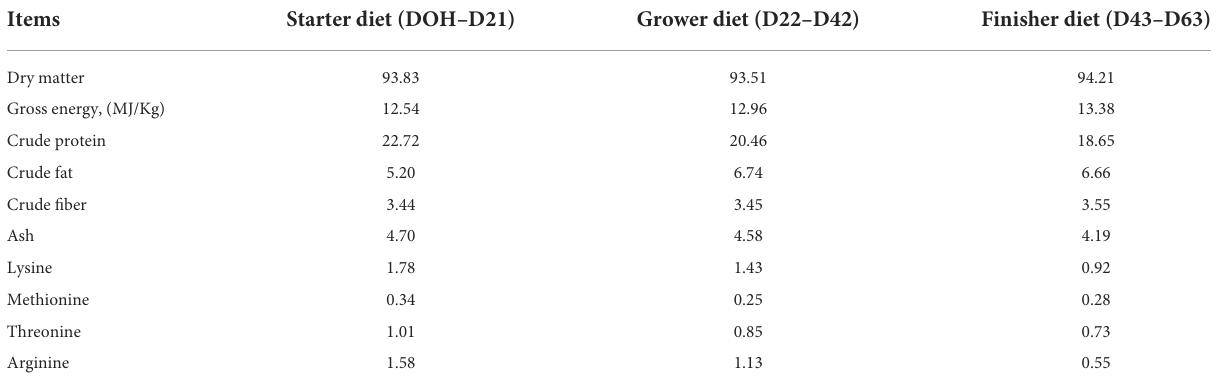
TABLE 1 Analyzed nutrient composition of the basal diets (as-fed basis, % unless stated